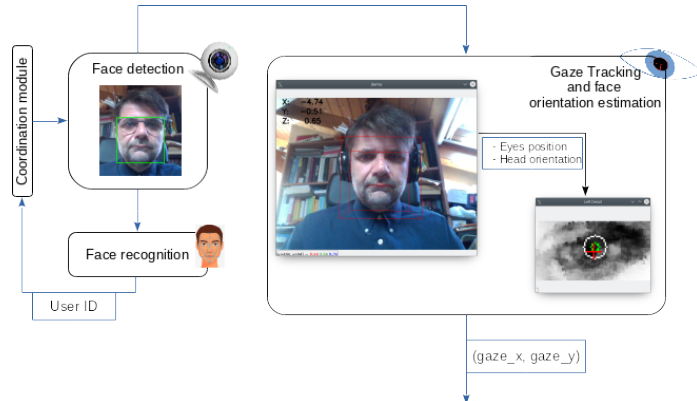
Figure 4. The MICA face processing